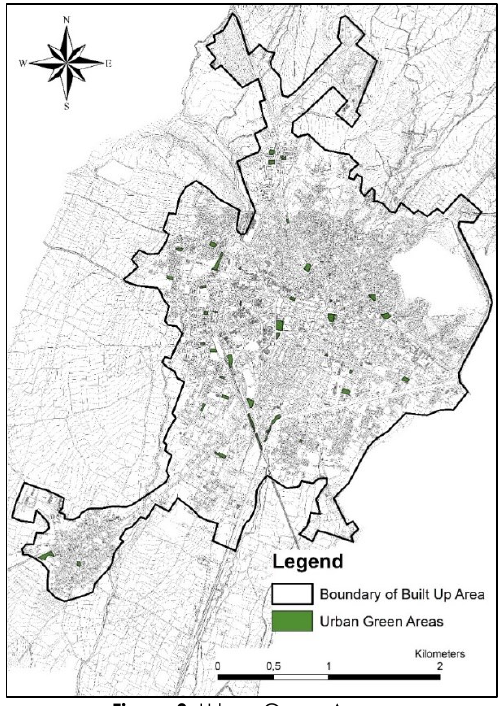
Figure 3. Urban Green Areas.